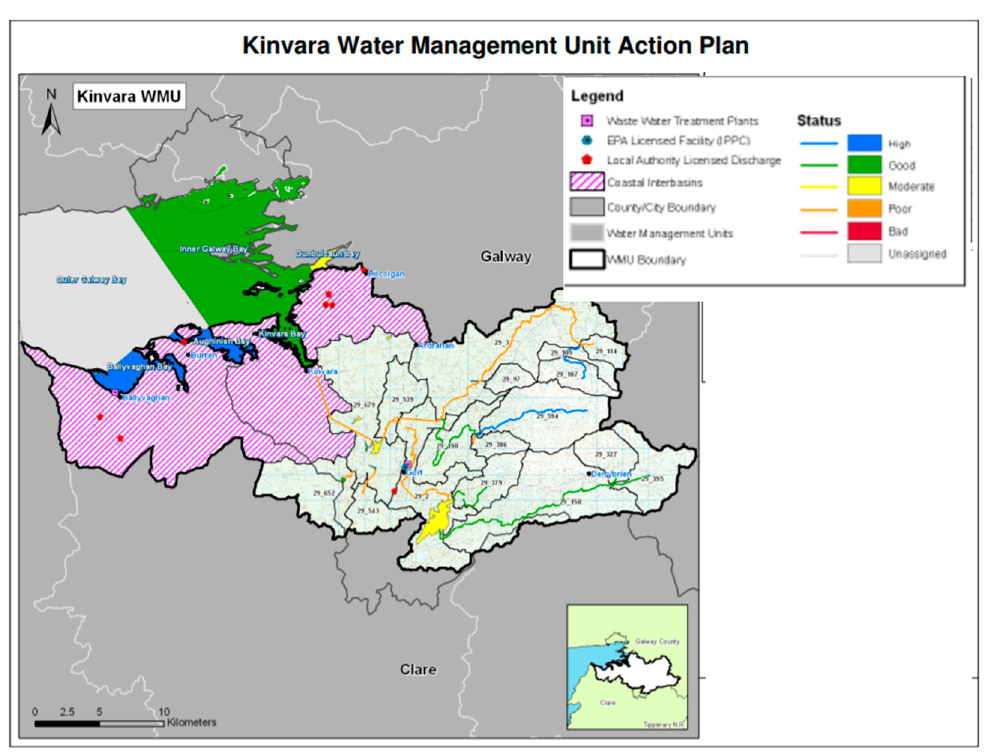
Figure 2. Kinvara catchment area (adapted from http://www.wfdireland.ie source).